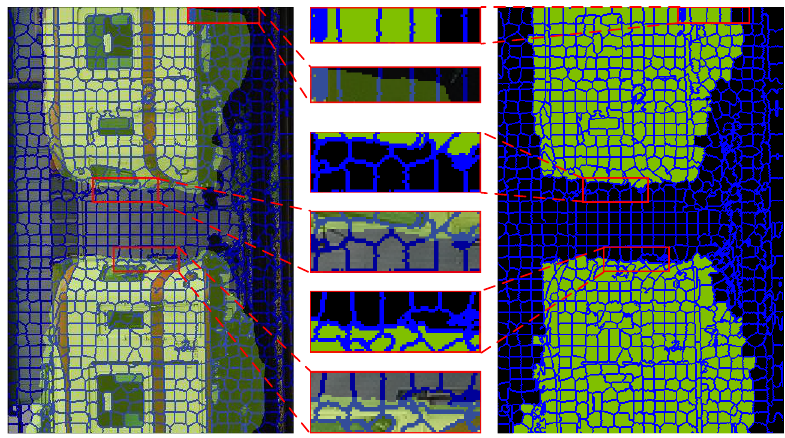
Figure 4. Boundary optimization and partial enlarged details.